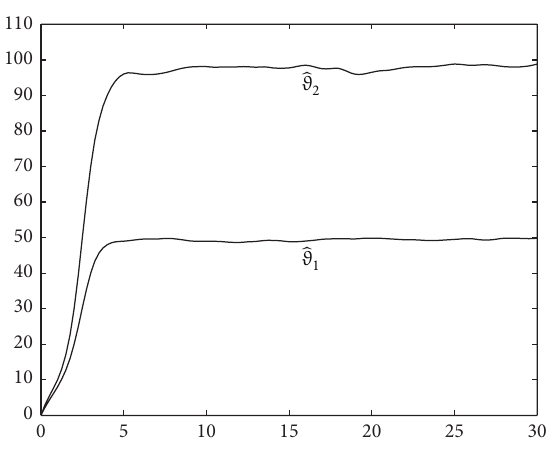
Figure 3: Control input 𝑢 .